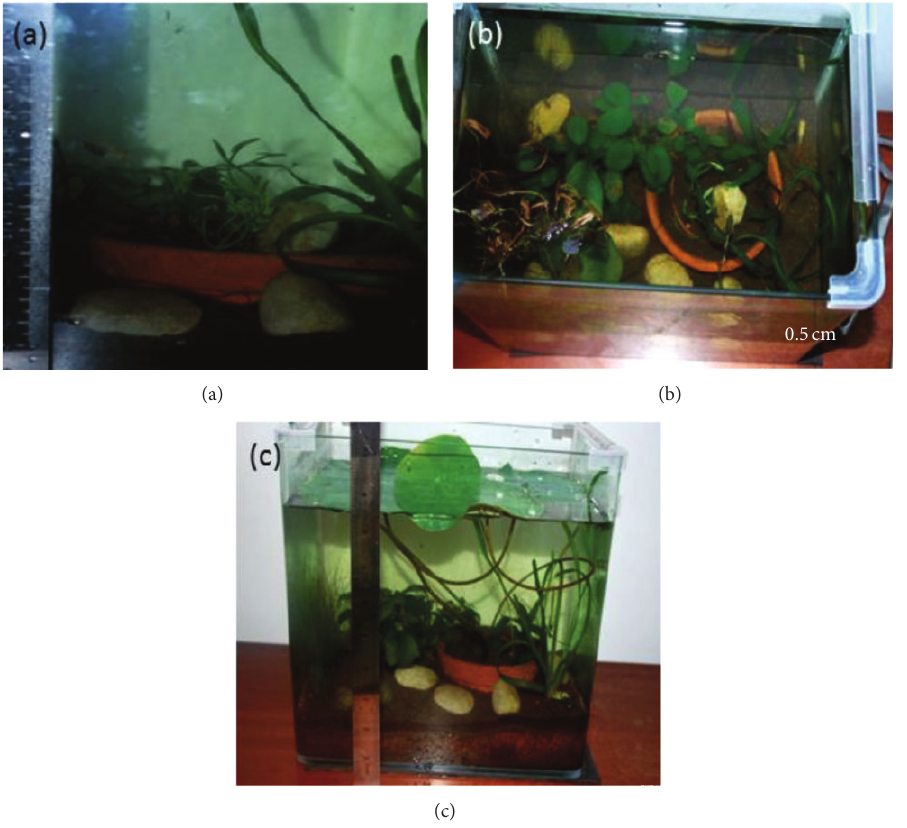
Figure 6: Acclimatization in fresh water aquarium mixed with black clay loam soil and associated with guppy fish. (a) Eight-month-old plantlets. (b) Shoots elongation. (c) Plantlets after 8 months of